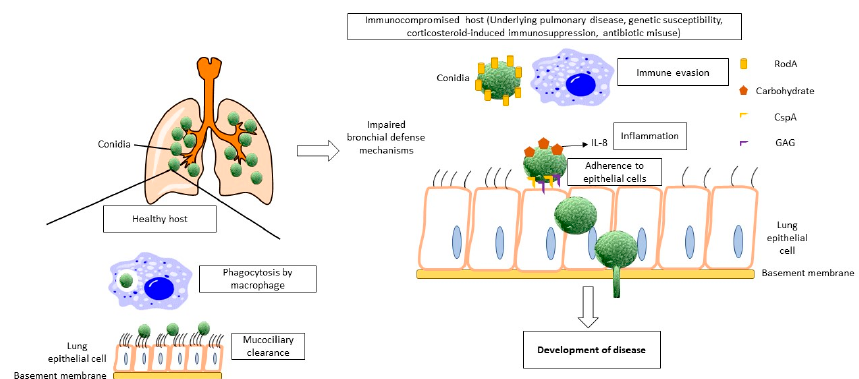
Figure 2. Pathophysiology of pulmonary aspergillosis.